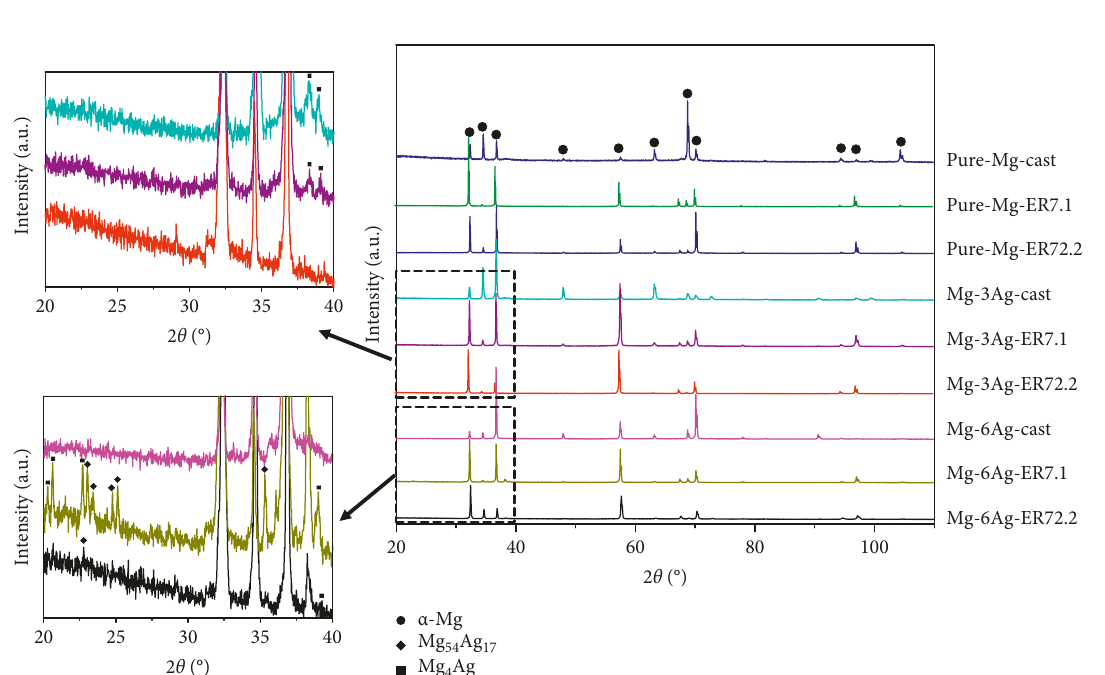
Figure 2: XRD results of pure Mg, Mg-3Ag, and Mg-6Ag with different extrusion ratios: 1 (as cast), 7.1, and 72.2.